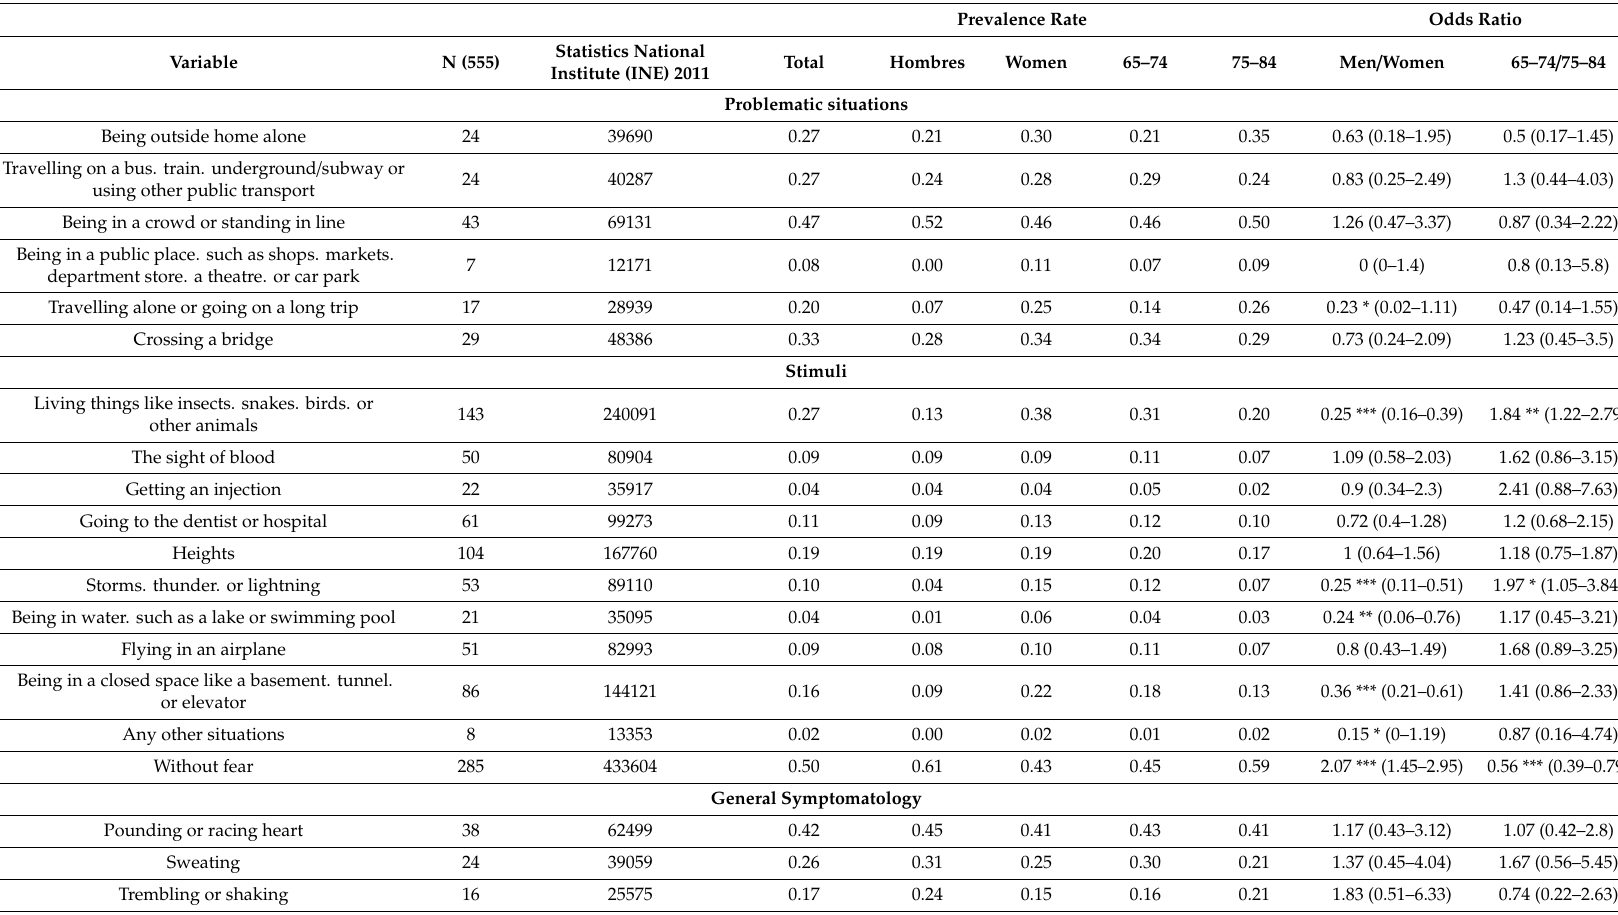
Table 4. Description of the symptoms of the specific phobia disorder in the Community of Madrid sample (problematic situations, phobic stimuli, and general symptomatology). Prevalence rate, 12 months, odds ratio for gender, age, and contrasts (OR =